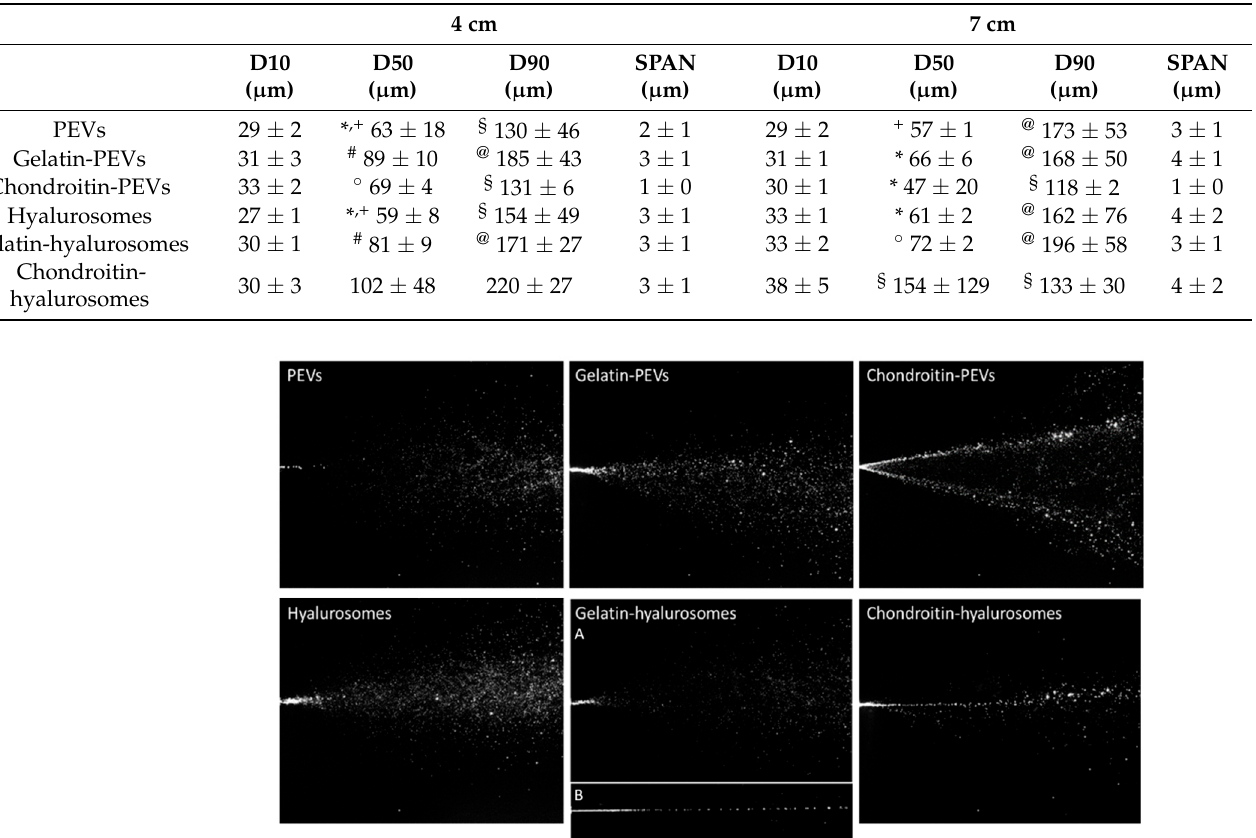
Figure 3. Representative images of instant visualization of plume generated by three consecutive sprays of PEVs; gelatin-PEVs; chondroitin-PEVs; hyalurosomes; (A, B) gelatin-hyalurosomes; and chondroitin-hyalurosomes.